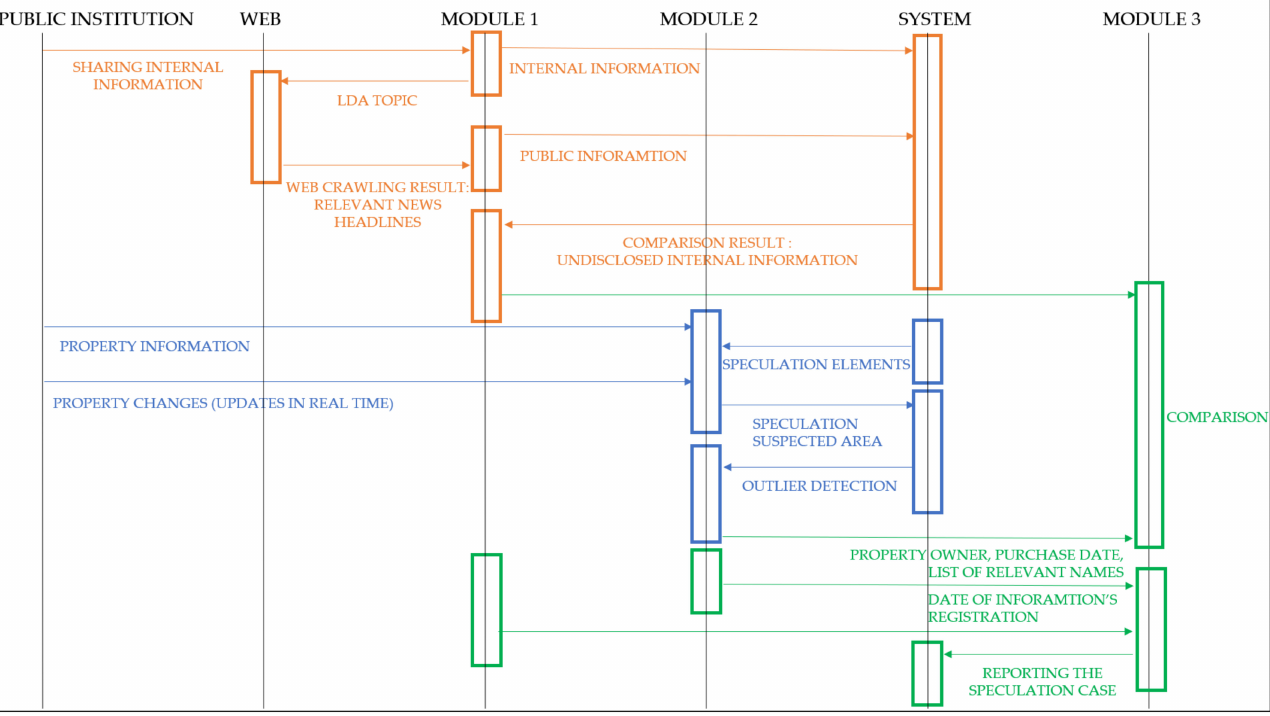
Figure 2. Flowchart showing how each module operates in the overall